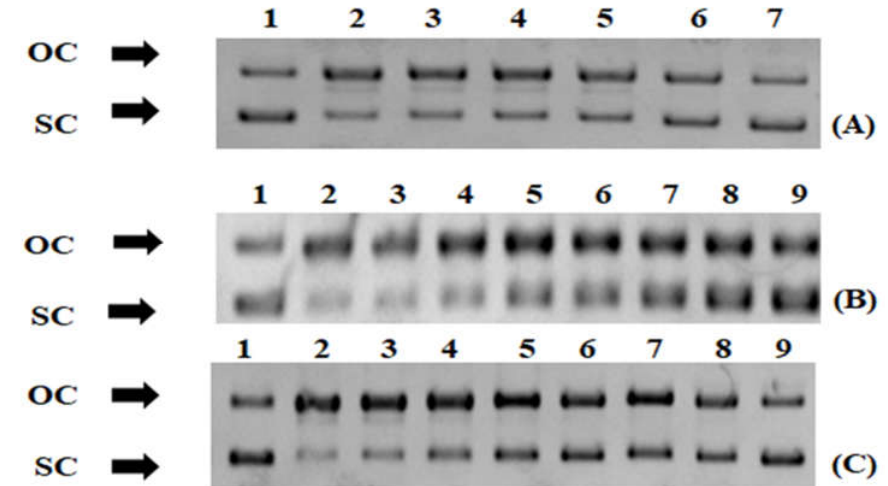
Figure 3. Representative photo of plasmid DNA gel electrophoresis showing protective activity of